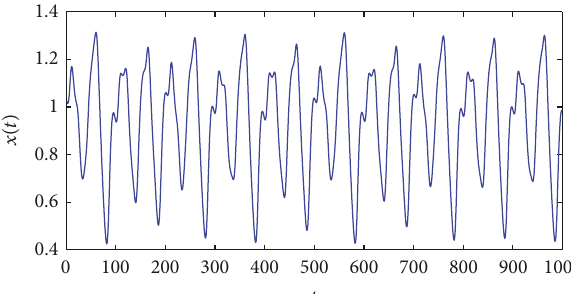
Figure 3: Time series generated from the Mackey-Glass equation.